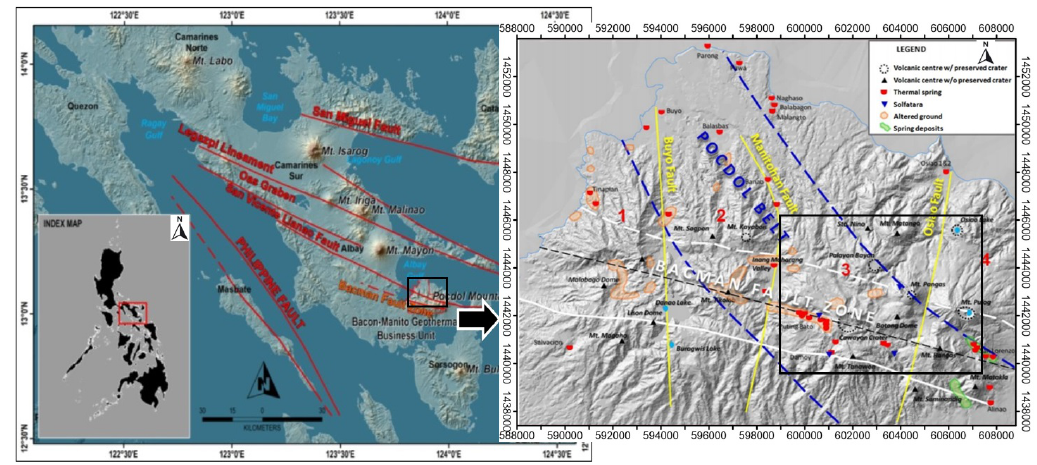
Fig. 1. Map of the study area location and faults structure in the Bac-Man geothermal field [2,